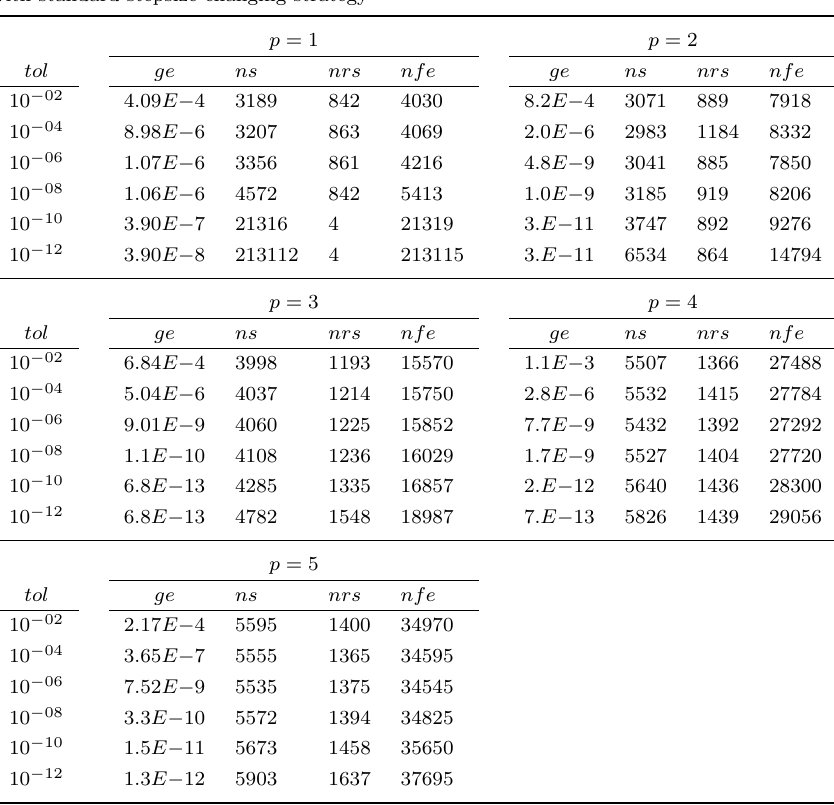
Table 5. Results of numerical experiments for van der Pohl equation (4.3) with standard stepsize changing strategy p = 1 p = 2